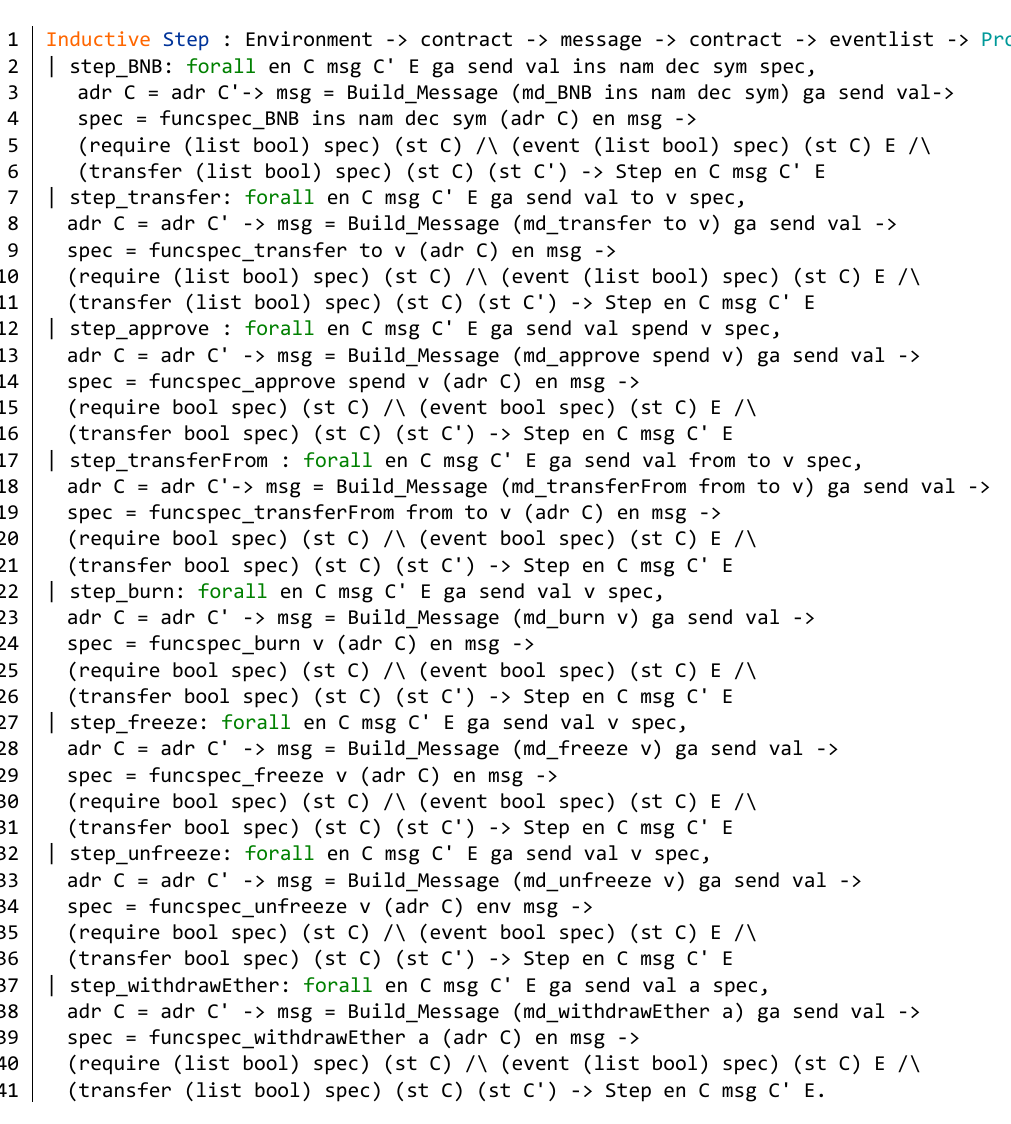
Figure A3. Evaluation step of the BNB